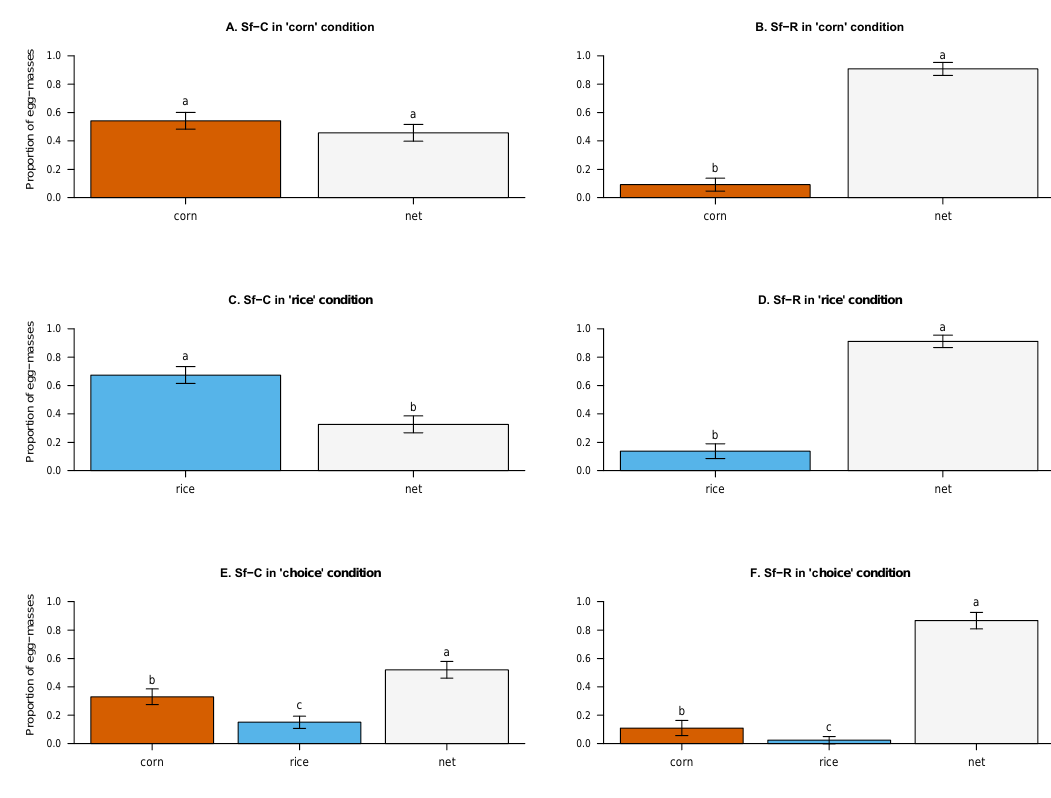
Figure 1 : oviposition choice of sf-C and sf-R. Proportion of egg masses laid in the three experimental trials (corn-only, rice-only and choice) by sf-C (A-C-E) and sf-R (B-D-F) according to the site of oviposition. There are three oviposition sites available: the net (light gray), the corn plant (red) and the rice plant (blue). Here, the relative proportions on each laying site represented the mean of proportions obtained about the four